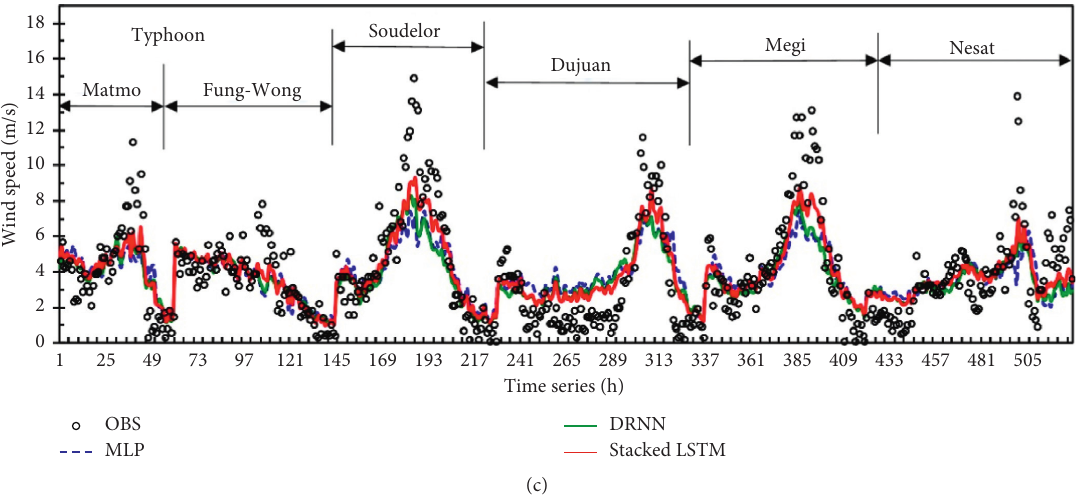
Figure 10: Predicted results of typhoons (2014–2017) in the testing set on the Taipei gauge for the lead times of (a) 1h, (b) 3 h, and (c) 6h.